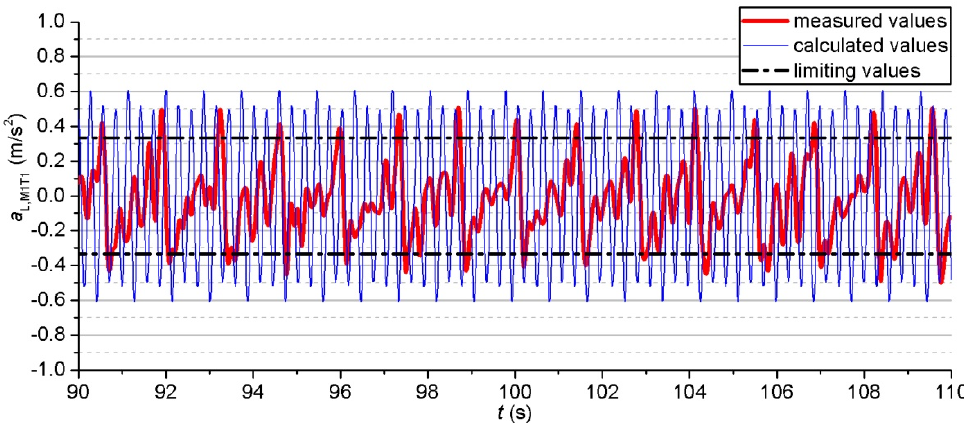
Figure 18. Measured vs. calculated values of the lateral accelerations of the referent point M1T1.